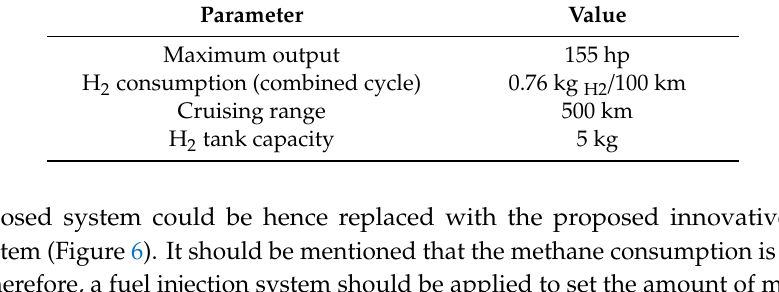
Table 4. The operating and geometric parameters of the on-board processor. Parameter